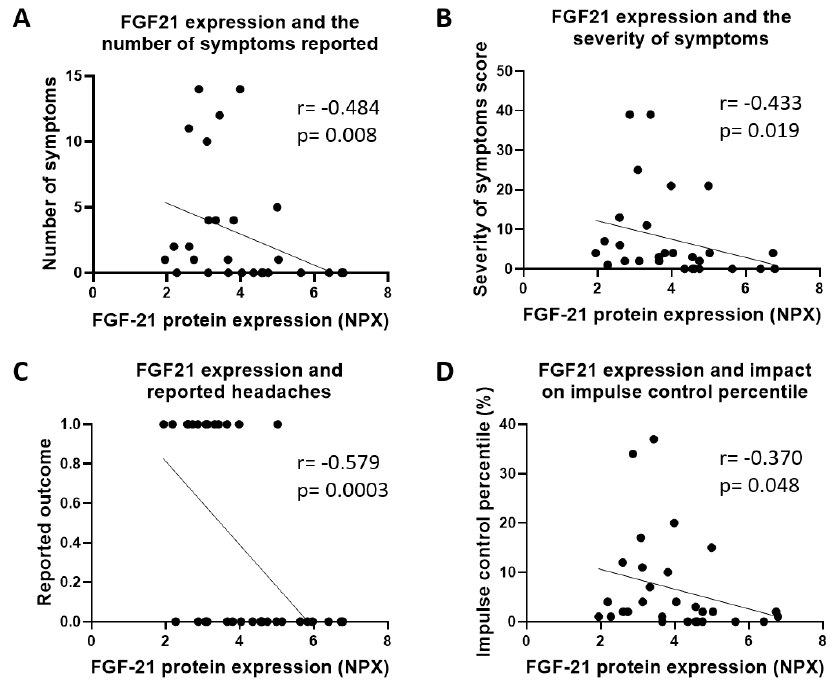
Figure 4. Fibroblast growth factor 21 (FGF21) protein expression correlated to clinical data. Reduced FGF21 protein expression was associated with increases in the ( A ) number and ( B ) severity of the symptoms such as ( C ) headaches. There was also a correlation of low levels of FGF21 and the ( D ) impact on impulse control. Data was analyzed according to Spearman’s correlation coe ffi cient where the number of pairs = 29 and p <